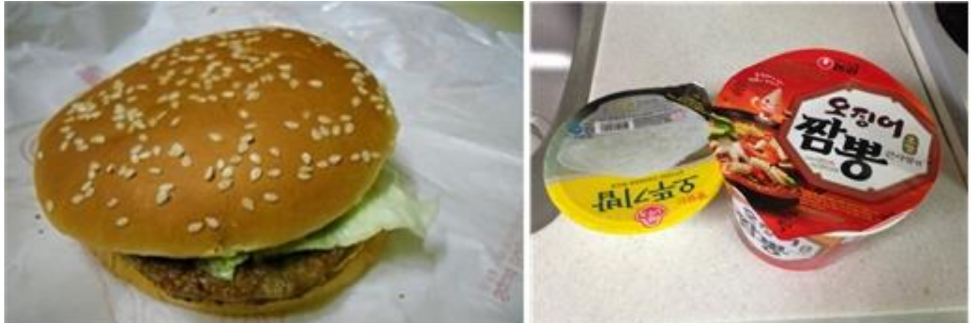
Figure 1. Pictures and statement depicting quick and simple